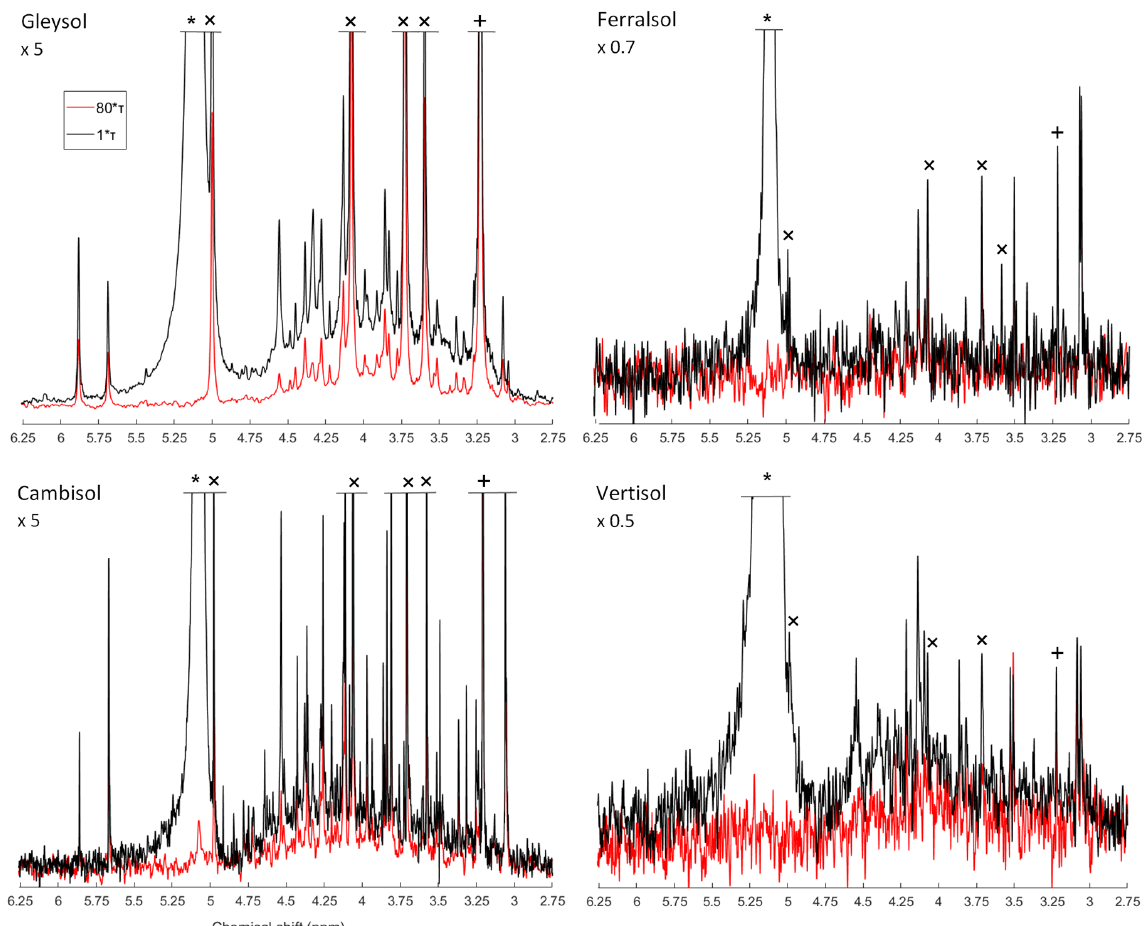
Figure 3. Solution 31 P NMR spectra of hypobromite oxidised soil extracts acquired with a CPMG pulse sequence with 1 ∗ τ (black) and 80 ∗ τ (red) spin-echo delays. The orthophosphate ( ∗ ), scyllo -IP 6 ( + ) and myo -IP 6 peaks ( × ) are marked accordingly. Spectra were normalised to the maximum scyllo -IP 6 peak intensity in the 1 ∗ τ spectrum for each soil. The vertical axes were increased or decreased for better visualisation by an indicated